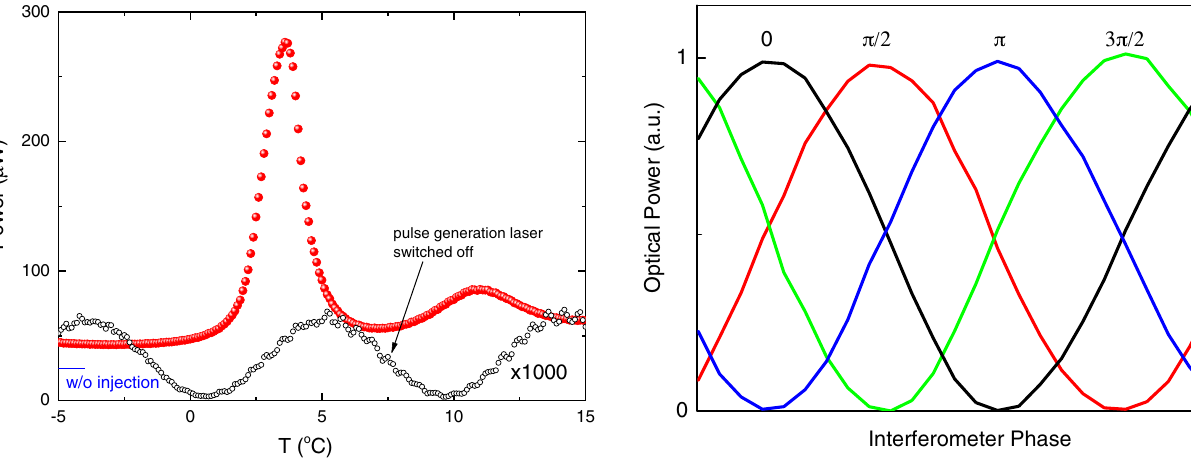
FIG. 6. Interference fringes recorded simultaneously for a repetitive modulation pattern of 0, π = 2 , π , and 3 π = 2